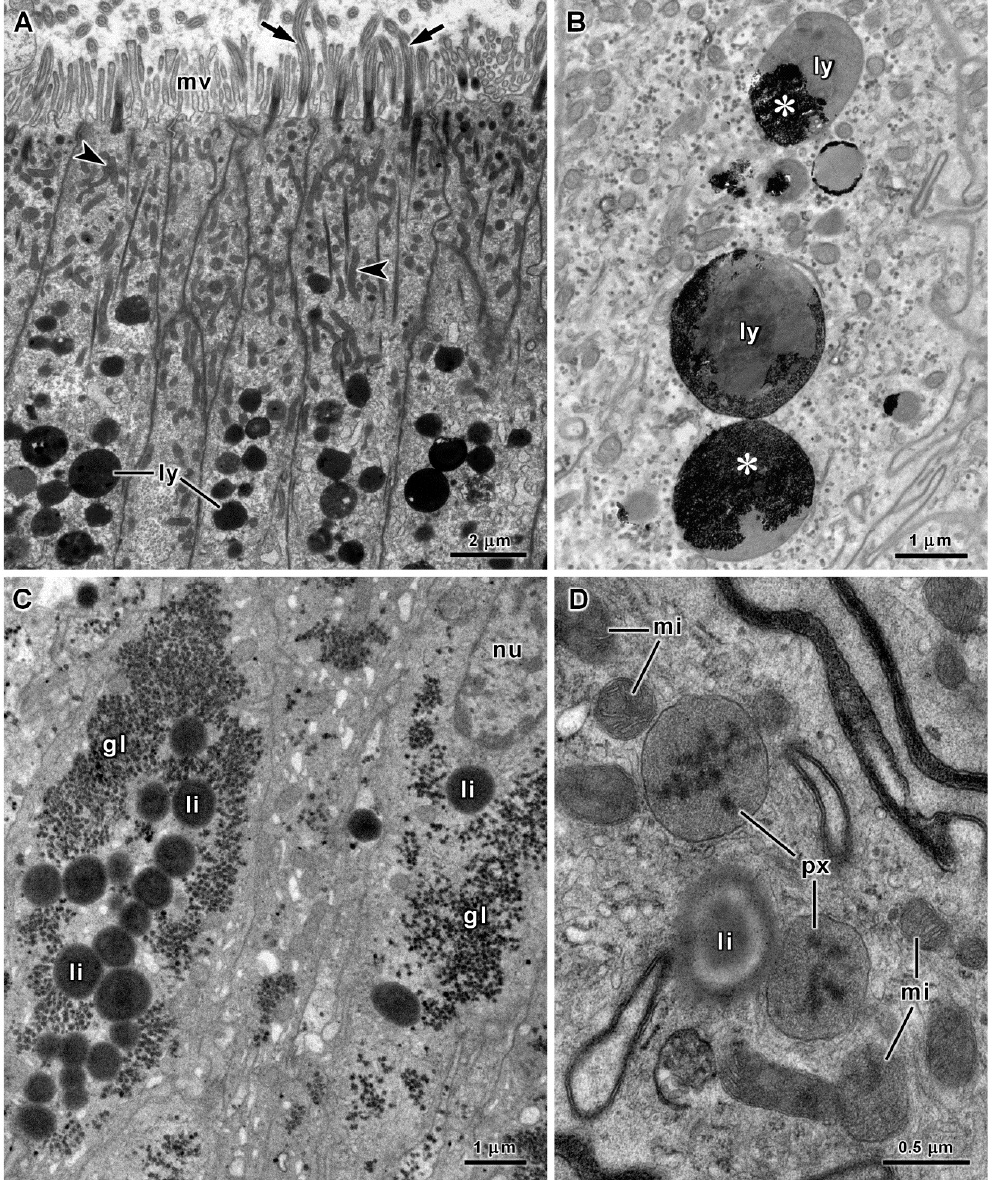
Figure 8. Ultrastructure of stomach absorptive cells in C. angulata ( A , B ) and A. fascicularis ( C , D ). ( A ) Apical region of the epithelium with a border of cilia (arrows) and microvilli (mv). Lysosomes (ly) and mitochondria (arrowheads) are abun- dant in the cytoplasm above the nucleus. ( B ) Lysosomes (ly) with electron-dense deposits (asterisks) resulting from aryl- sulphatase detection. ( C ) Glycogen deposits (gl) and lipid droplets (li) in the cytoplasm below the nucleus (nu). Ultrathin section stained with tannic acid and uranyl acetate. ( D ) Peroxisomes (px) in association with mitochondria (mi) and a lipid droplet (li).